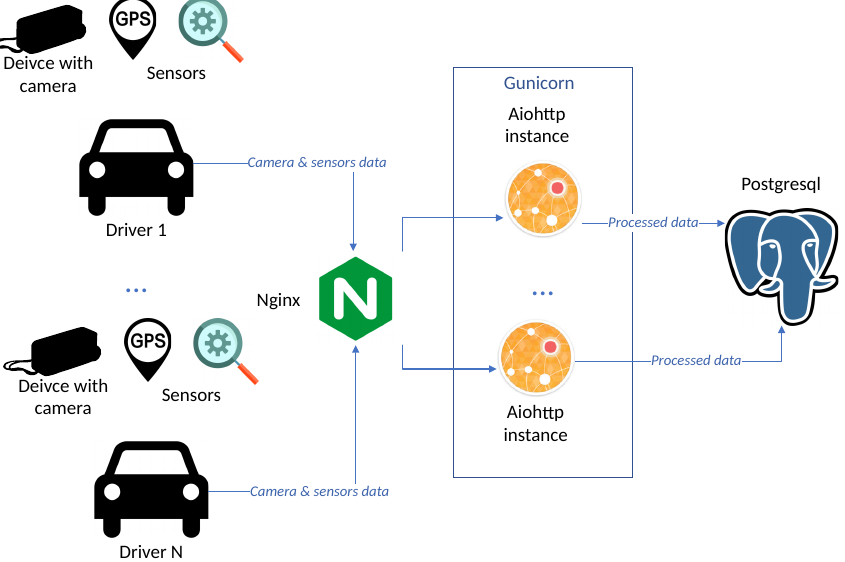
Figure 3. Drive Safely data gathering